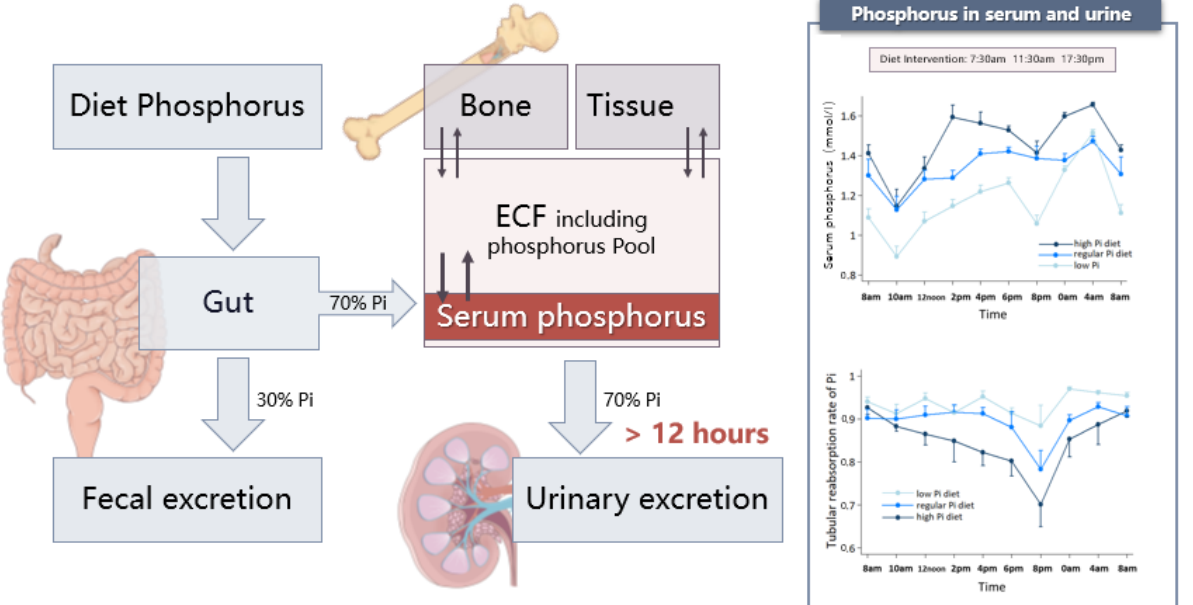
Figure 3. Phosphorus transport among three organs, tissue, and ECF. Note: Gut and kidney handle the major fraction of daily phosphorus transport for absorption and excretion. Urinary excretion of phosphorus lasts for at least 12 h to finally reach phosphorus balance. The phosphorus pool acts as a buffer pool throughout the slow excretion process of the kidney to ensure that the serum phosphorus is in a narrow range. The arrows mean the exchange between different tissues or organs.